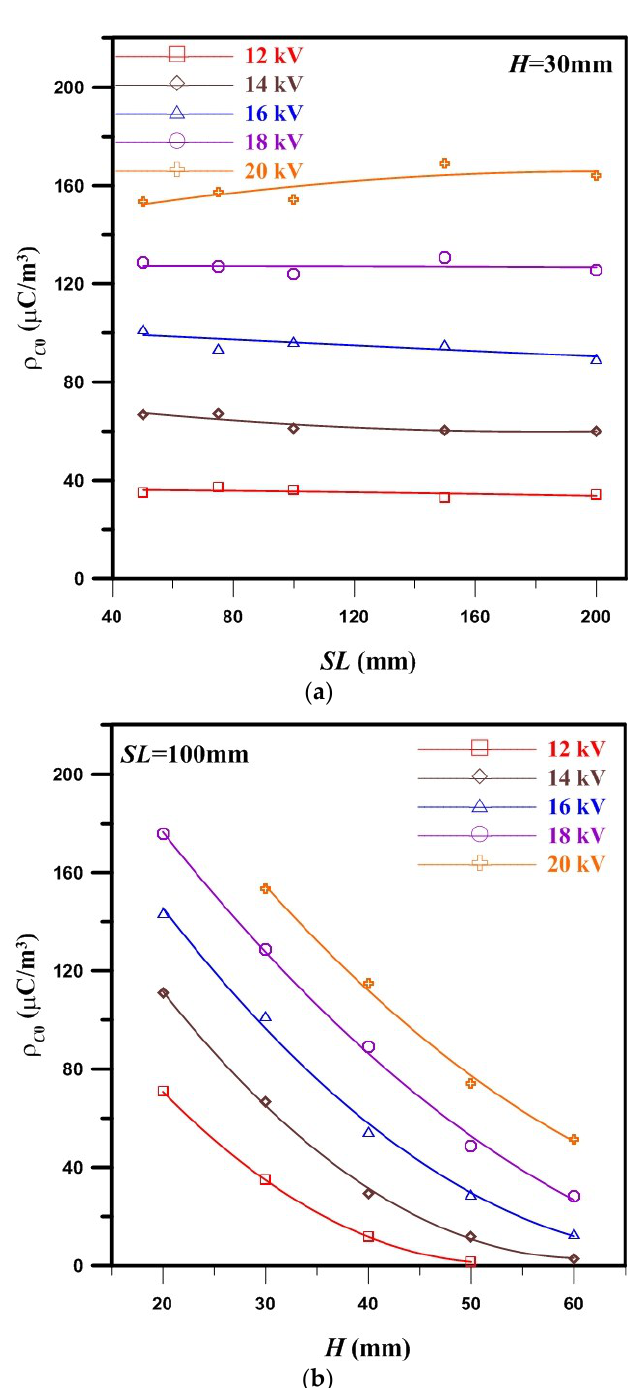
Figure 6. The variations of the charge density ρ c 0 at different electrode heights H and pitches SL with different applied voltages. ( a ) H = 30 mm; ( b ) SL = 100 mm.